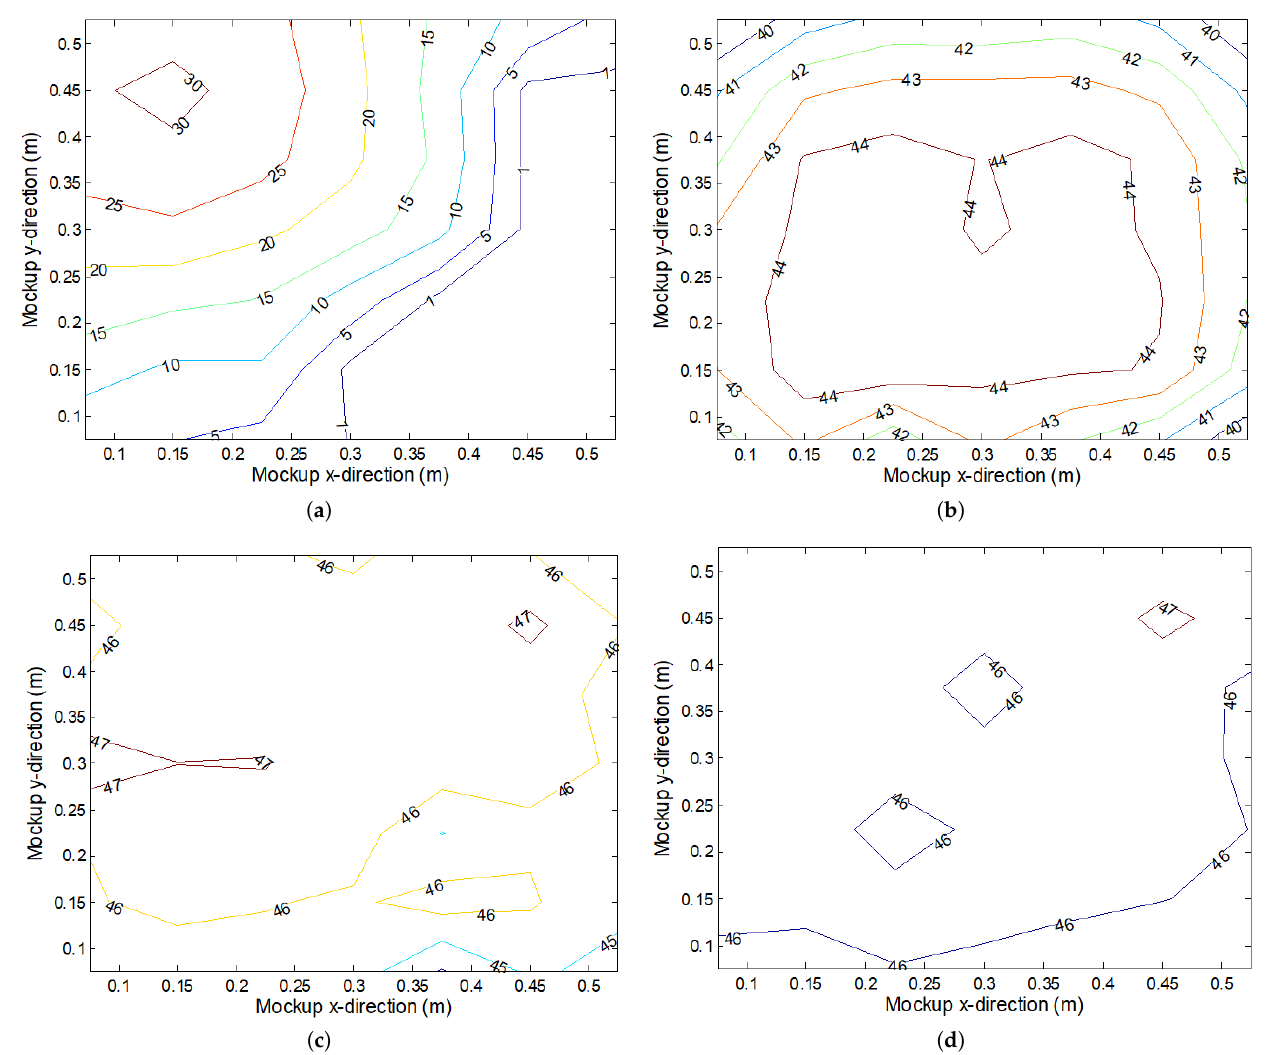
Figure 17. Summary of throughput maps for different configurations (if not specified, the receiver points vertically upward): ( a ) One-lamp transmission. ( b ) Four-lamp transmission without walls. ( c ) Four-lamp transmission with walls. ( d ) Four-lamp transmission with walls and receiver oriented as defined by Equation